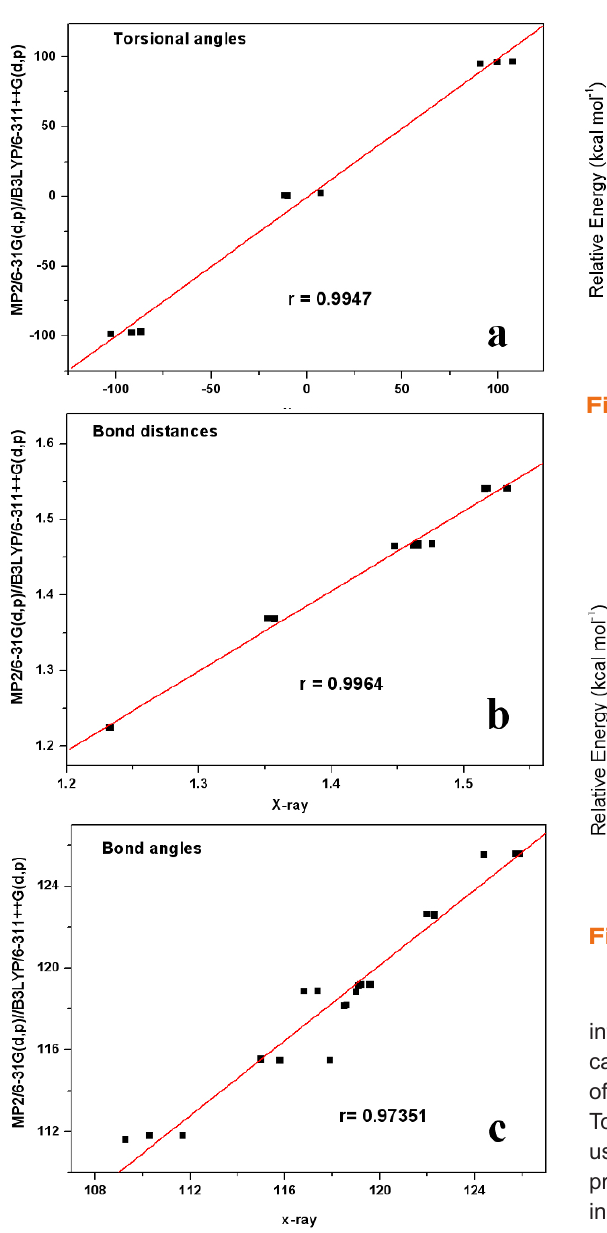
Figure 2. A graph showing the correlation between theoretical calculations obtained from MP2/6-31G(d,p)//B3LYP/6- 311++G(d,p) calculations versus experimental data (X-ray, [15]). a) bond distances; b) bond angles and c) dihedral angles.